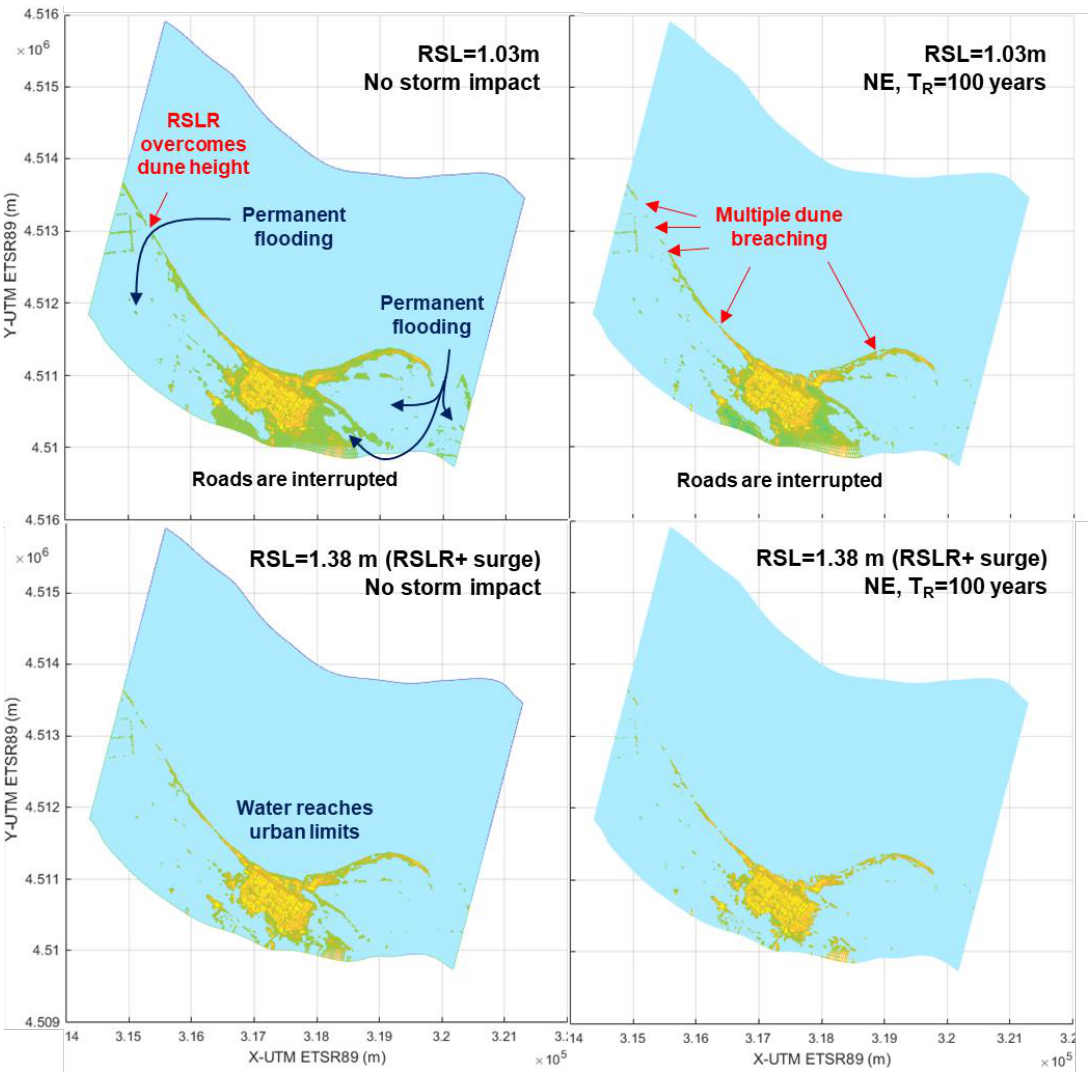
Figure 8. Flood map before (left) and after (right) the impact of a northeastern storm of 100-year return period. Left panels can be considered as the effect of static sea level (i.e., bath-tub approach). Top pictures correspond to scenario 5 (future climate, 2100 SLR, no storm surge), while bottom pictures are associated to scenario 6 (future climate, 2100 SLR, storm surge). Green areas represent emerged elevation below 1 m; whereas yellow areas are above 1 m.